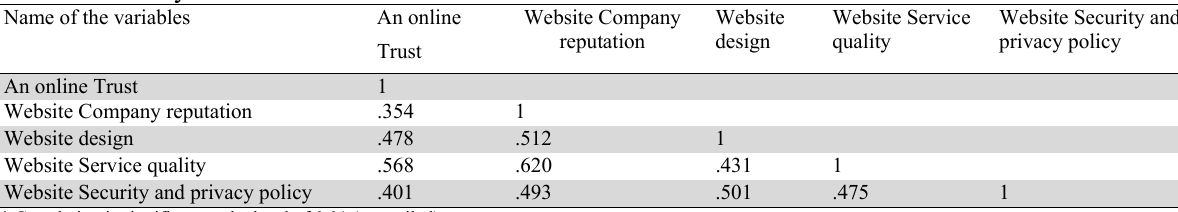
Correlation analysis